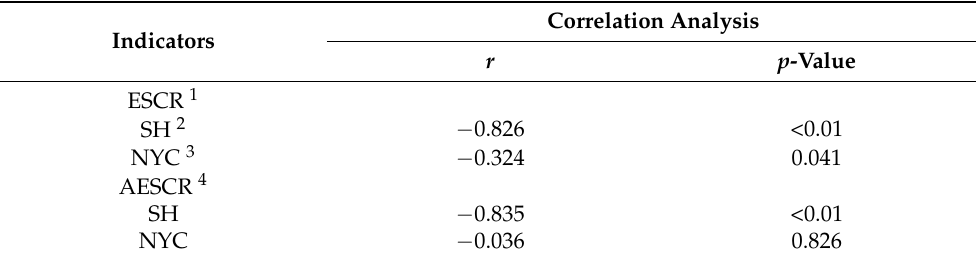
Table 2. Analysis of the Relationship Essential Women’s Healthcare Service Coverage Rate (ESCR),